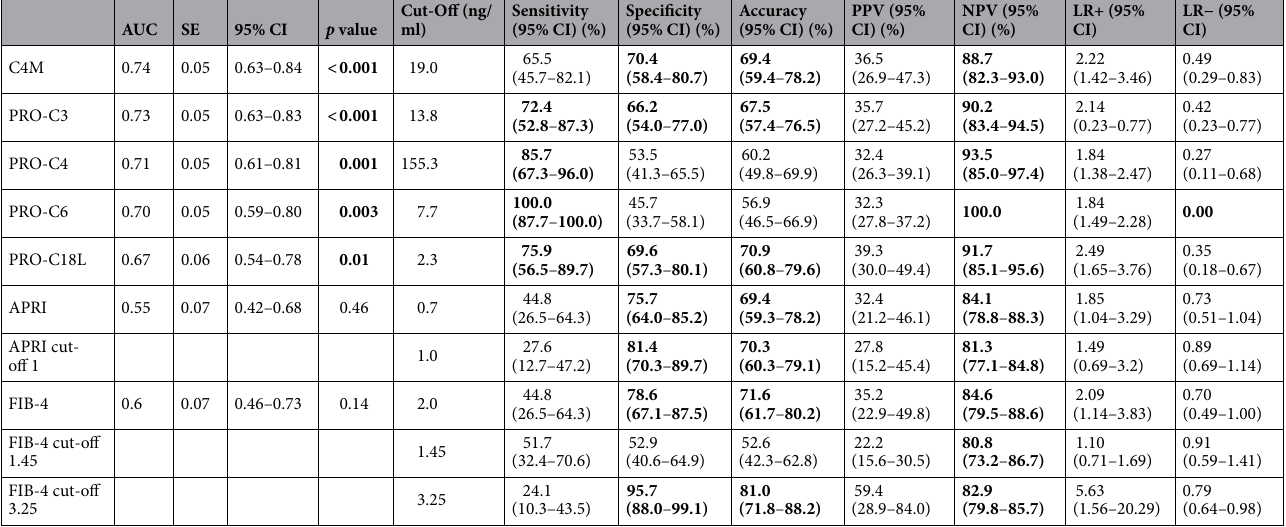
Table 2. Summary of test performance of ECM biomarkers, APRI and FIB-4 for the detection of liver graft fibrosis. Sensitivity, specificity, accuracy, PPV, NPV, LR+ and LR− are shown including the 95% CI. If CIs for sensitivity, specificity, accuracy, PPV and NPV did not include 50%, values are depicted in bold. p values of AUC < 0.05 were regarded as significant and are depicted in bold. SE standard error, PPV positive predictive value, NPV negative predictive value, LR + positive likelihood-ratio, LR− negative likelihood-ratio.